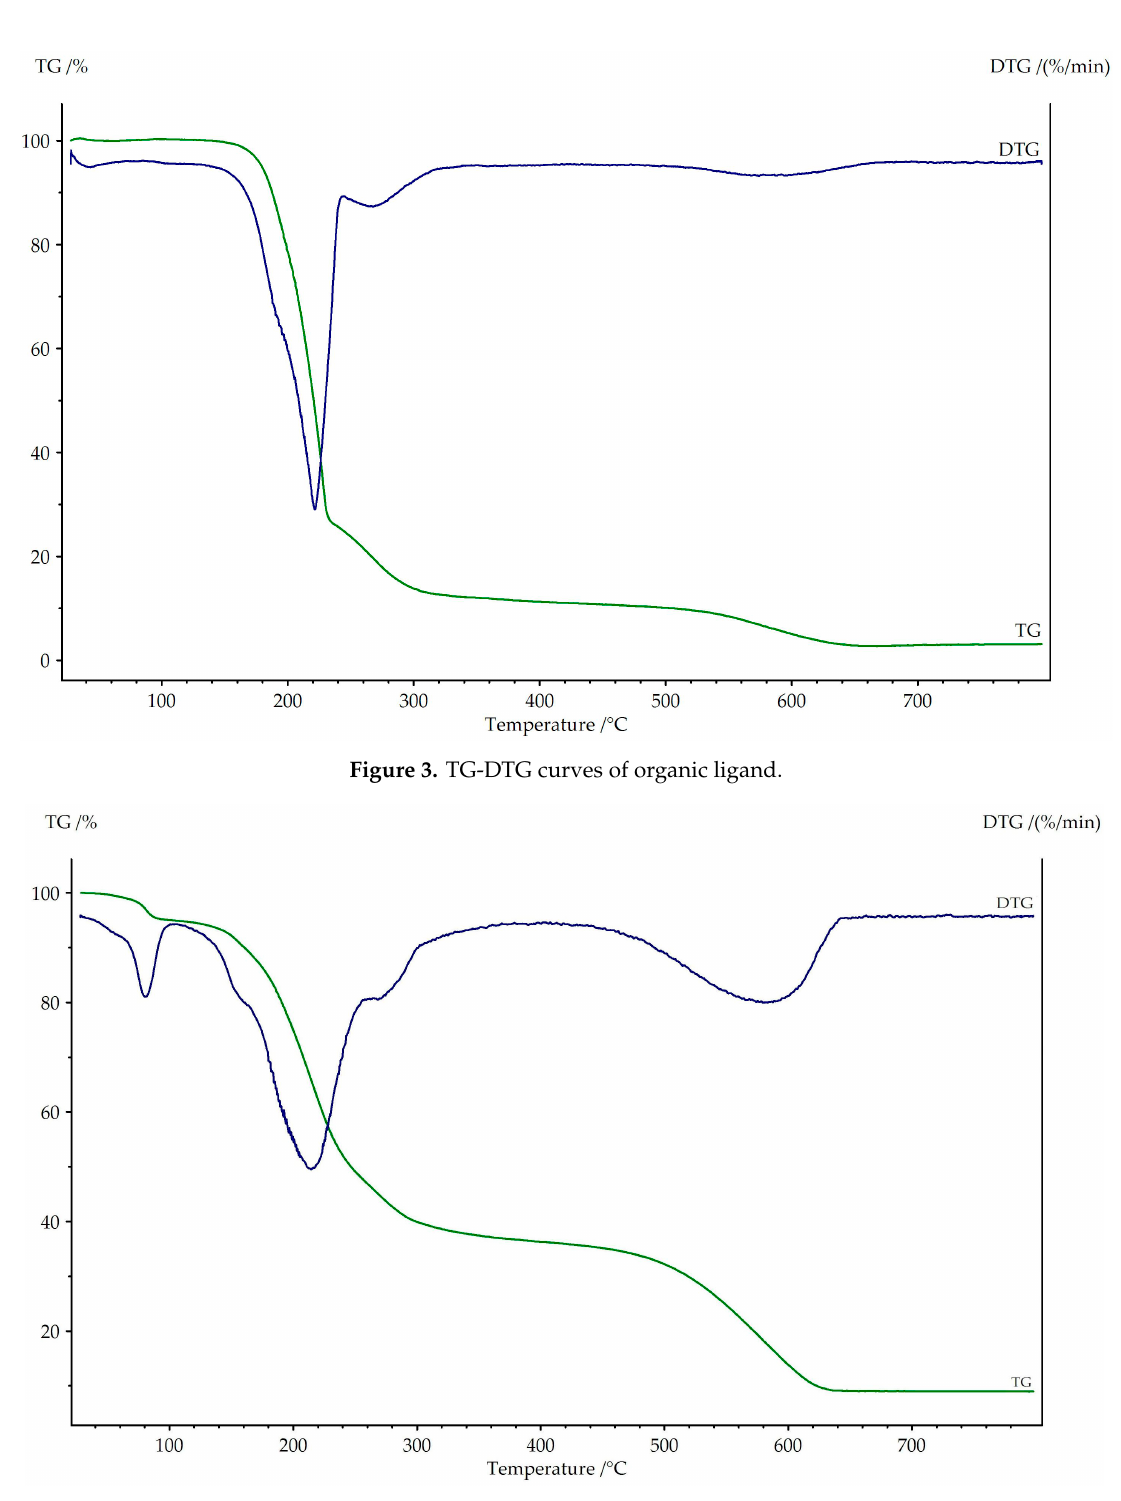
Figure 4. TG-DTG curves of copper(II) complex.